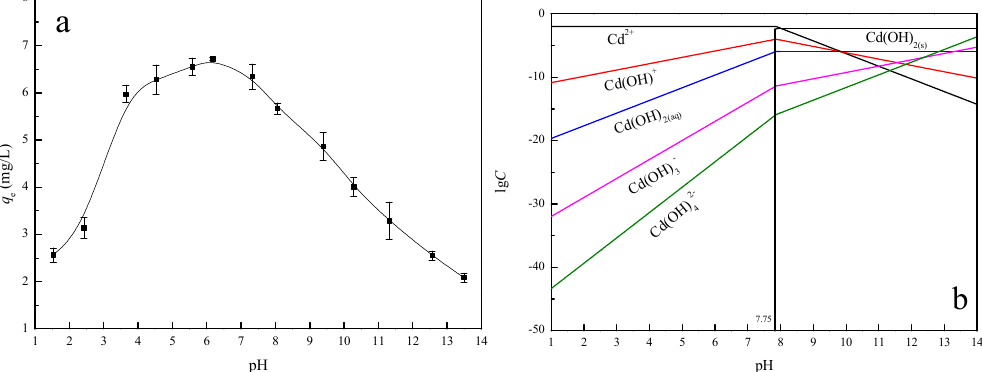
Figure 5. ( a ) The effect of initial pH of Cd(II) solution on the adsorption capacity of IB; and ( b ) Logarithmic diagram of Cd(II) hydrolysis components ( c = 0.1 mmol·L − 1 ). ( b ) Logarithmic diagram of Cd(II) hydrolysis components ( c = 0.1 mmol · L − 1